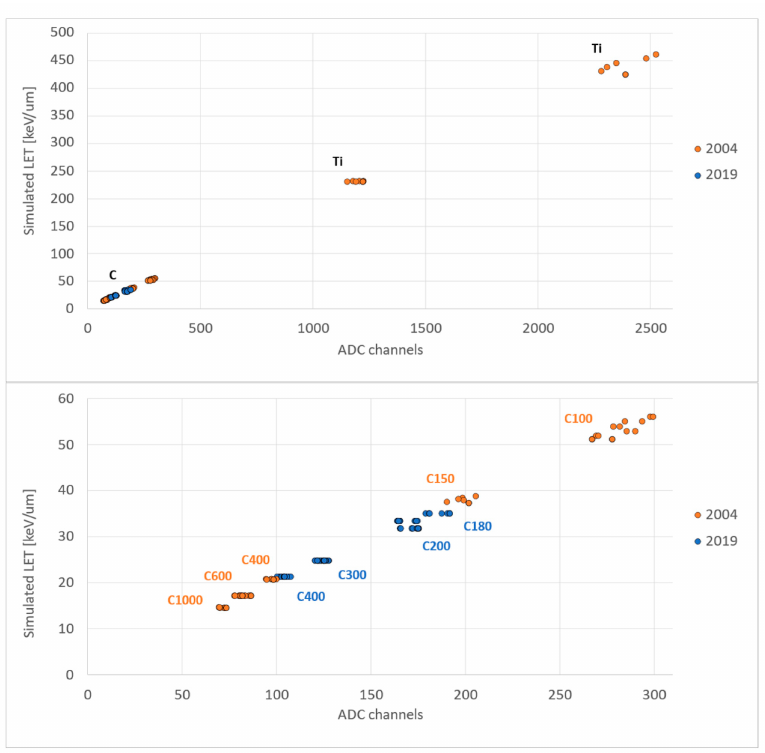
Figure 7. Simulated particles’ LET/plane vs. experimental data for all the silicon planes of SDU0 from the 2019 measurement session at CNAO (blue dots) and 2004 measurement sessions at GSI-Darmstadt (orange dots).